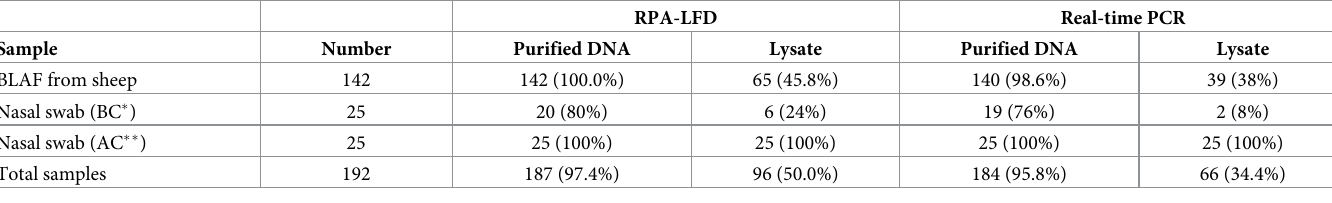
Table 3. Comparison of M . ovipneumoniae RPA-LFD and real-time PCR using clinical